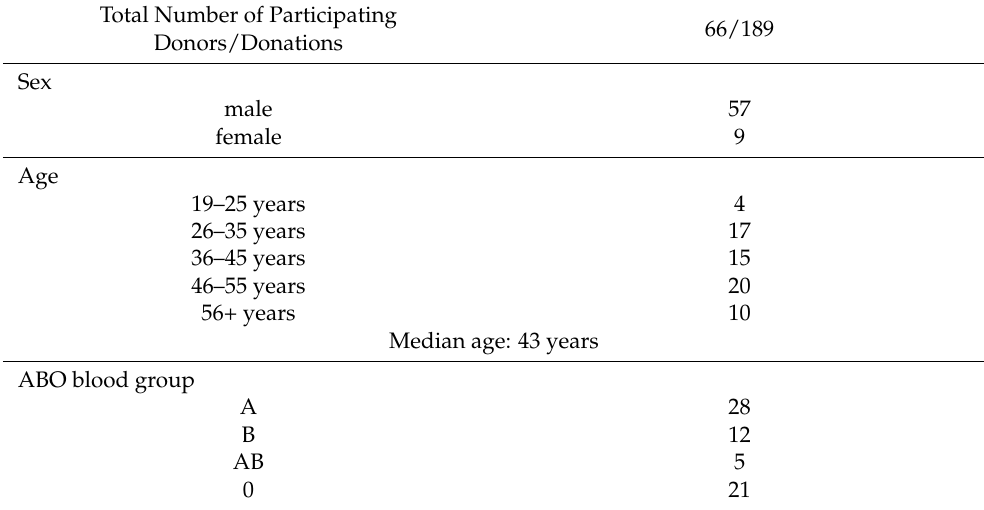
Table 1. CP donor study